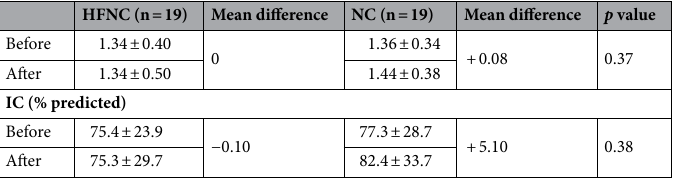
HFNC (n = 19) Mean difference NC (n = 19) Mean difference p value